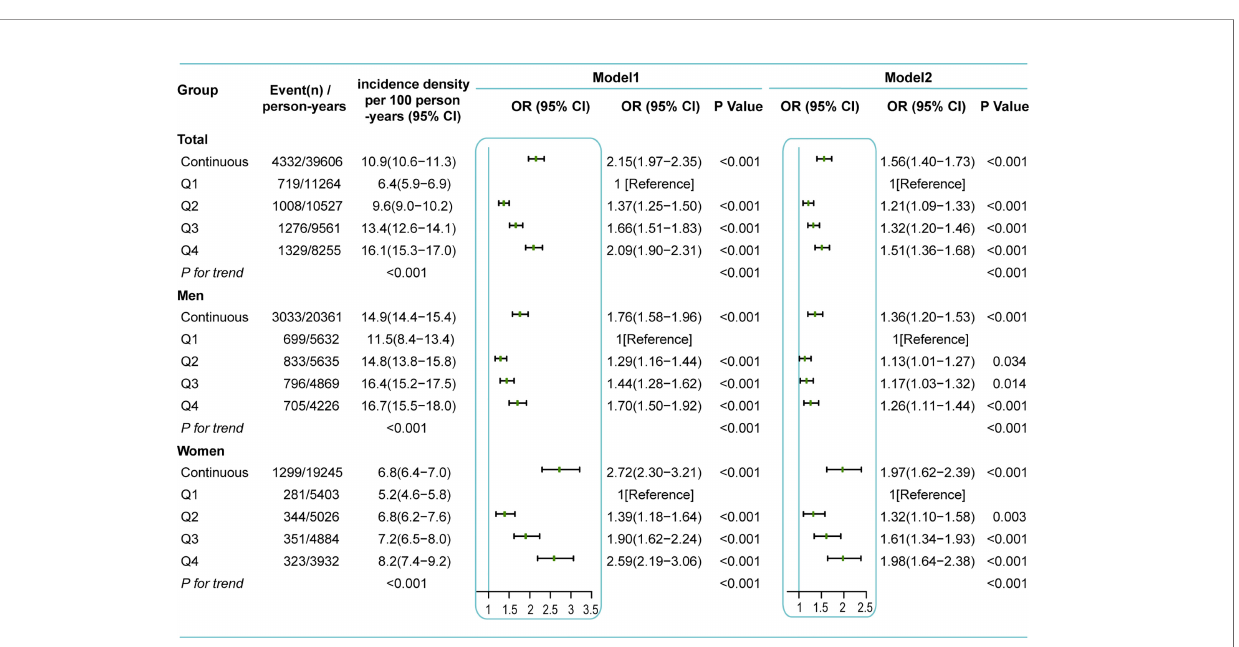
Frontiers in Endocrinology |